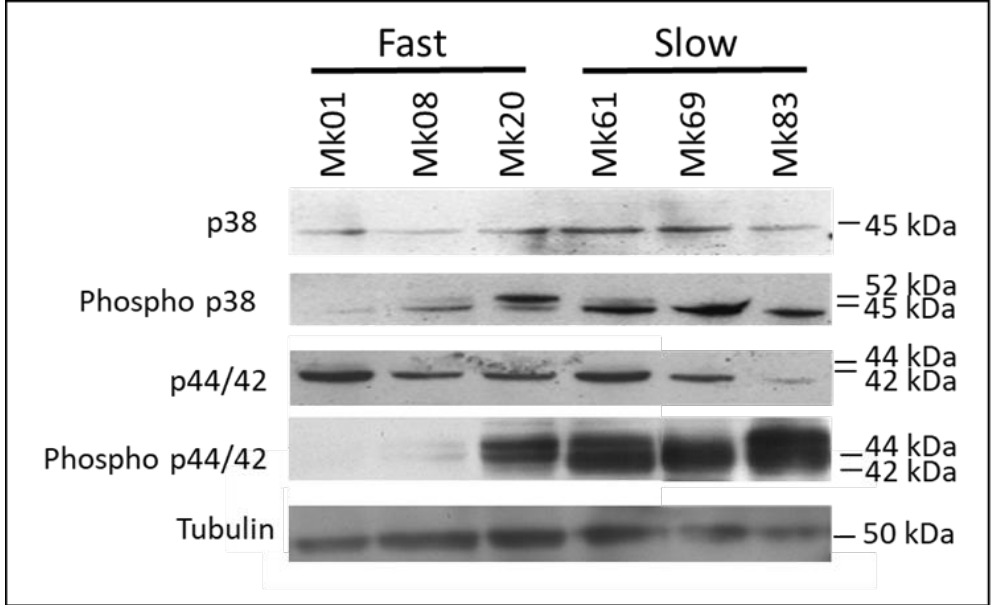
Figure 7. p38 and p44/42 MAPK in monokaryons of F- and S-subpopulations. Twenty five micrograms of total protein extract from three fast (Mk01, Mk08, and Mk20) and three slow (Mk61, Mk69, and Mk83) growing monokaryons cultivated in SMY liquid medium for seven days were subjected to immunoblot analysis with an anti-phospho-p38 MAPK antibody and an anti-phospho-p44/42 MAPK antibody to detect phosphorylation of these MAPKs. A monoclonal α -tubulin antibody was used as a loading control. The intensity of the phosphorylation signal is inversely correlated with the growth rate of mycelia.